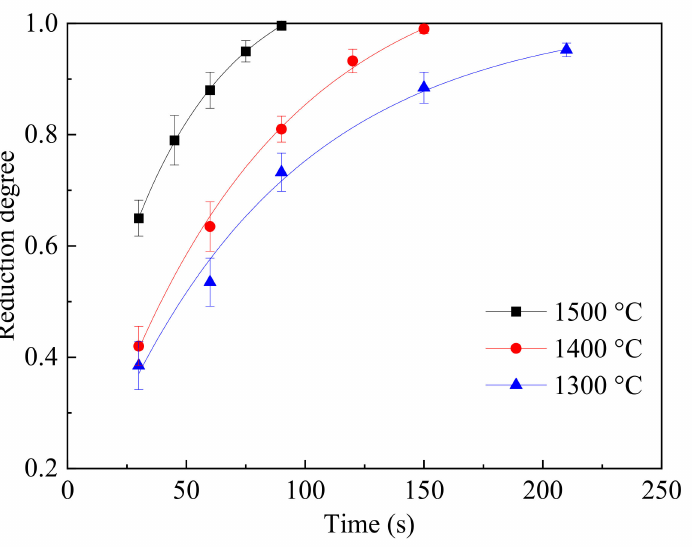
Figure 9. The relationship between the reduction degree and reduction time at different